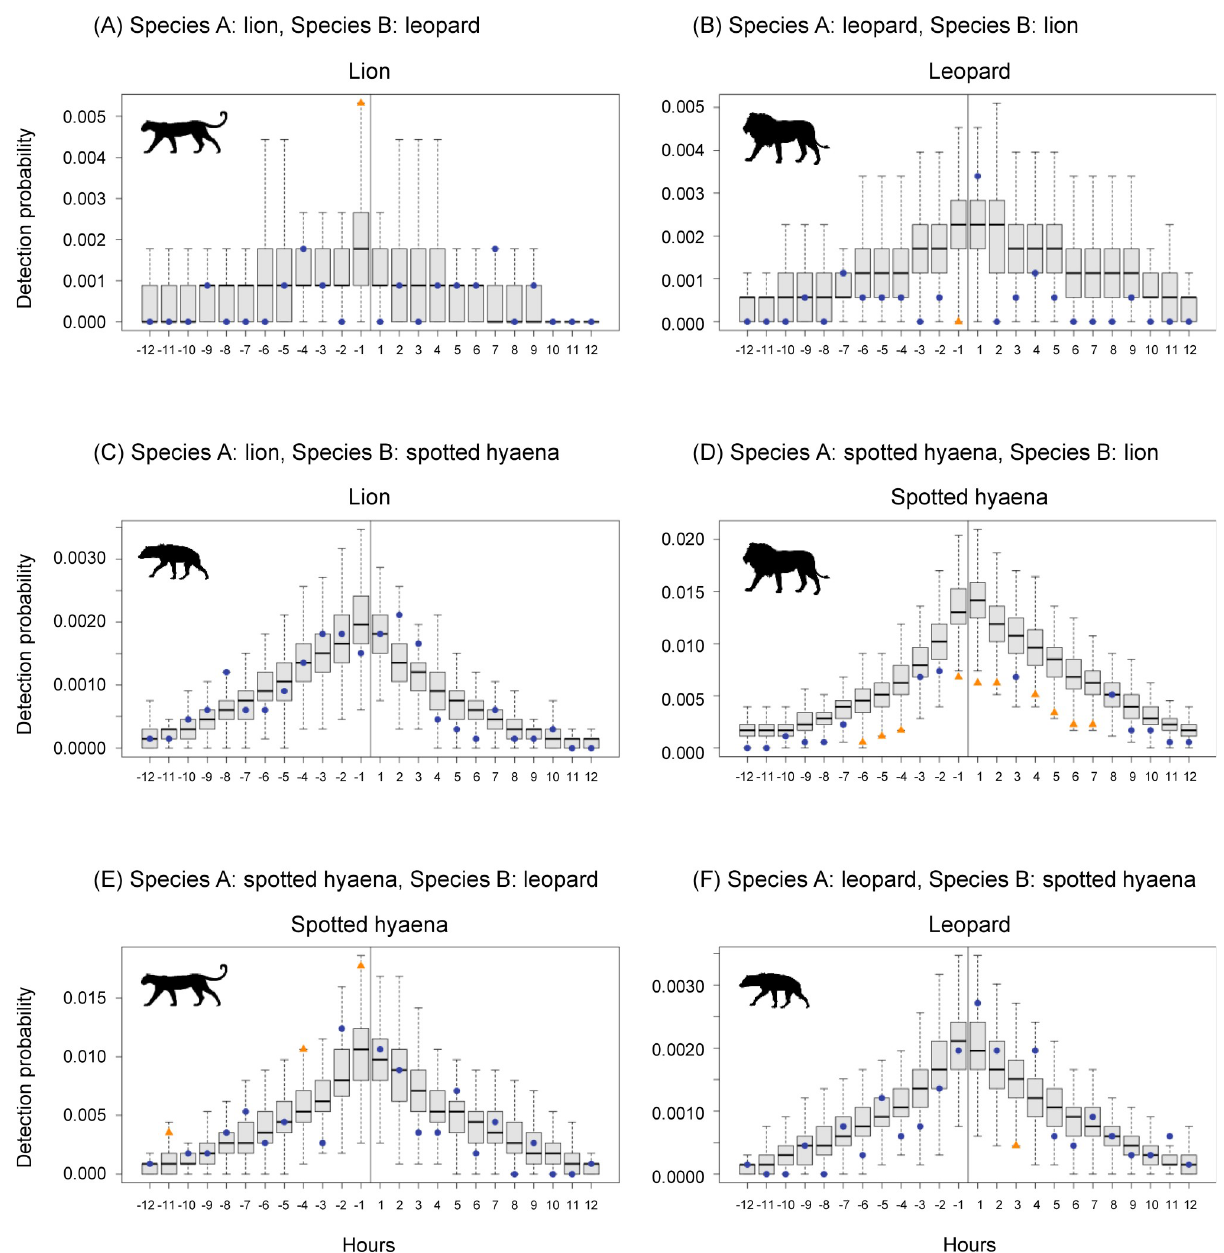
Fig 3. Detection probability of species B (shown via silhouettes) in the 12 hours before and after a capture of species A (at hour 0) at the same station, divided into one-hour units. Boxplots show the expected probability of detecting species B in each hour before and after capture of species A if there were no relationship between detections of species A and species B, while points indicate the observed detection probability of species B for each hour before and after capture of species A. Expected detection probabilities were derived by randomly sampling 1000 times from the observed activity pattern probability density function for that species. Observed detection probabilities that differ significantly (p < 0.05) from the expected probability of detection are shown with orange triangles; those that do not differ significantly are shown with blue